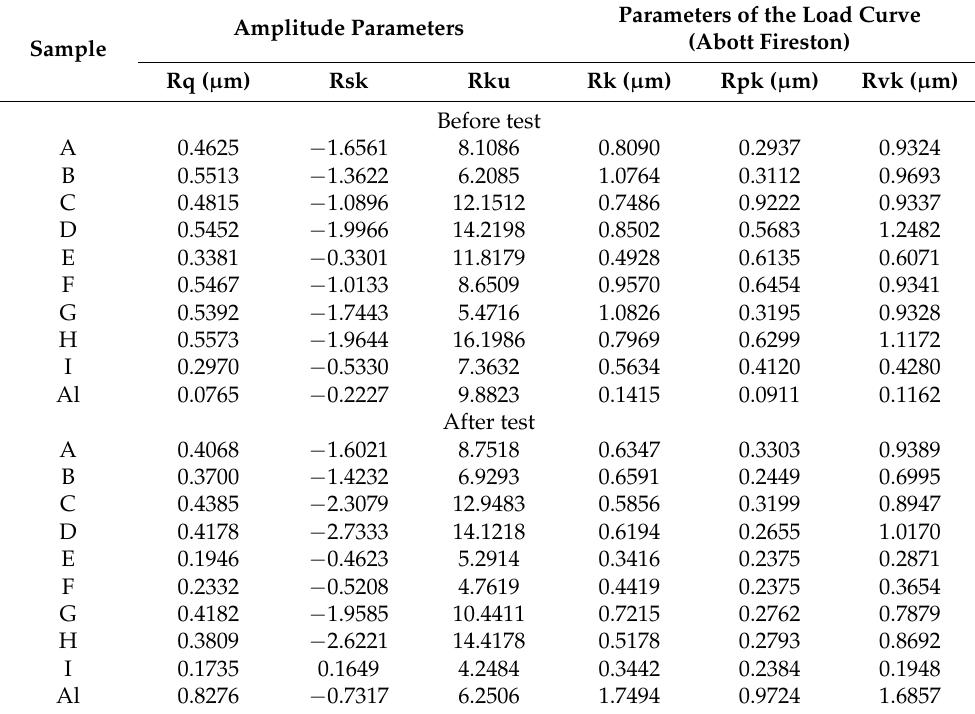
Table 5. Amplitude parameters and parameters of the load capacity curve of layers before and after